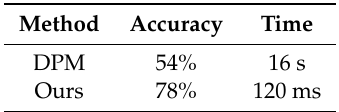
Table 6. Comparison of accuracy and